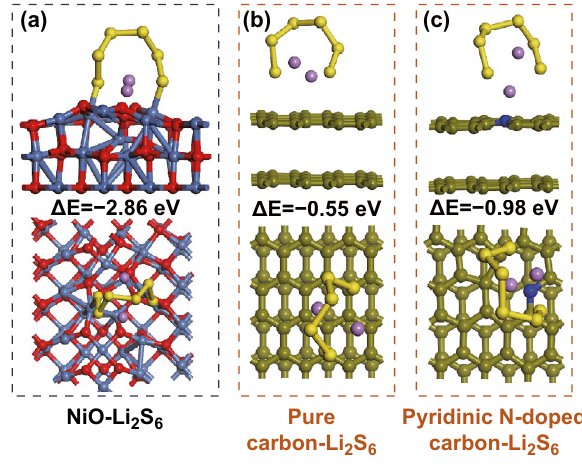
Fig. 7 DFT calculations on adsorption energies between NiO, pure carbon, and pyridinic-N-doped carbon with Li 2 S